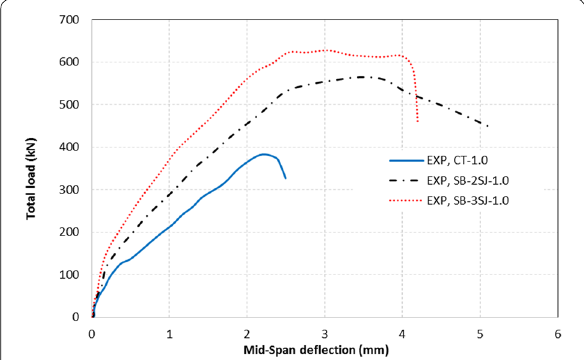
Fig. 11 Load–deflection curves of all beams with a / d